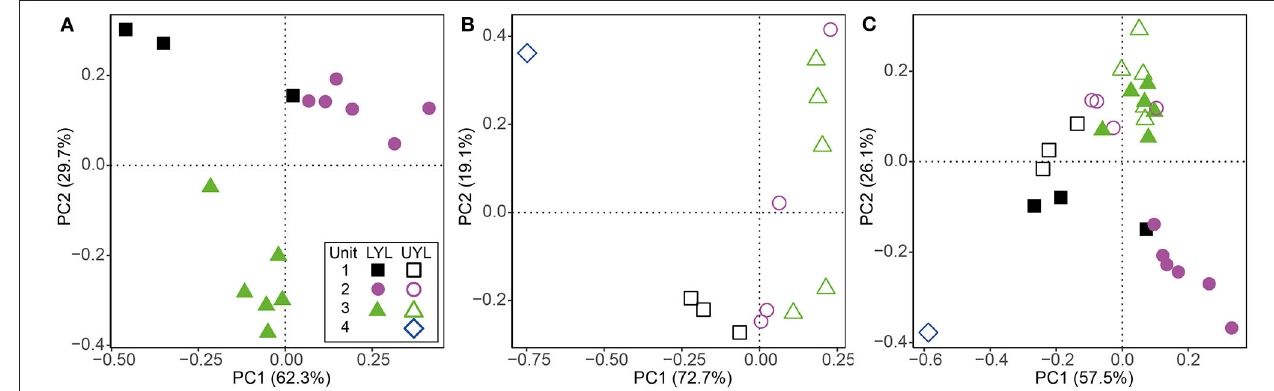
FIGURE 4 | Ordination plot for first and second axes of variance from PCA of physical and XRF variables. (A) LYL (filled shapes), (B) UYL (hollow shapes), and (C) YL. Unit 1: black squares; unit 2: purple circles; unit 3: green triangles; unit 4: blue diamonds. Axis labels denote the percentage of total variance explained by the respective principal components